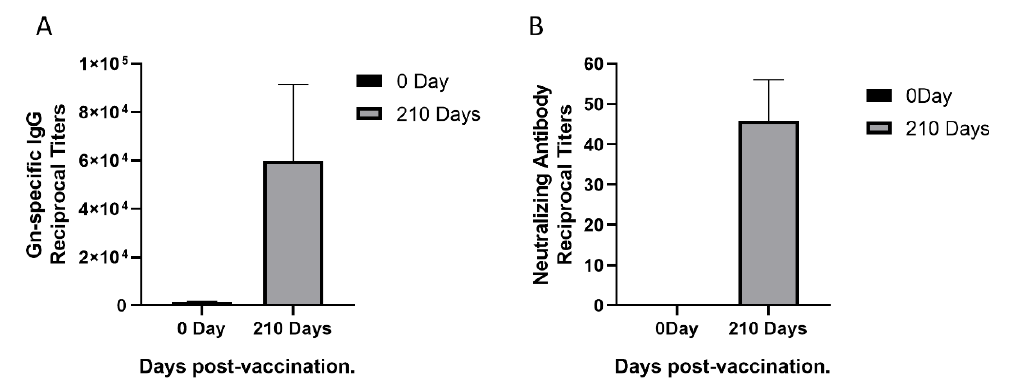
Figure 1. Sera response in a rhesus monkey immunized with recombinant human adenoviruses type 4 expressing Rift Valley fever virus Gn and Gc protein (rHAdV4-GnGcopt). ( A ) Serum samples were collected at 0 and 210 days after immunization and subjected to ELISA analysis of IgG antibodies to the Rift Valley fever virus (RVFV) Gn. The titers were calculated as reciprocal endpoints. The cutoff values were calculated as the mean optical density of control serum (1:8100 dilution) multiplied by 2.1. Data are presented as the means ± standard deviations (error bars) from three independent trials. ( B ) Serum samples were collected at 0 and 210 days after immunization and subjected to virus neutralization test via RVFV MP-12 strains expressing eGFP (RVFV-SeGFP). The neutralizing antibody titers were calculated using the Reed–Muench method. Data are presented as the means ± standard deviations (error bars) from three independent trials.